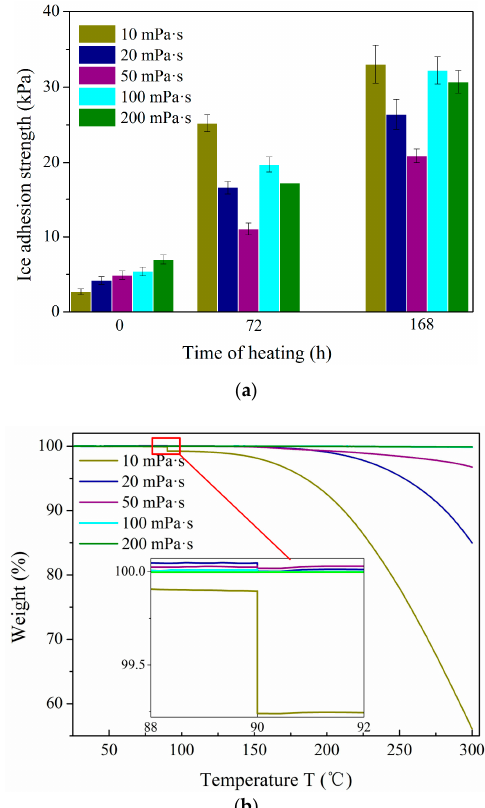
Figure 9. ( a ) Variation in the ice adhesion strength of the SLIPS filled with different viscosities (10– 200 mPa·s) of silicone oil after the heat-resistant test at 90 °C. ( b ) Thermogravimetric curve of silicone oil with different viscosities (10–200 mPa·s). The inset shows the enlarged part marked by the red box.